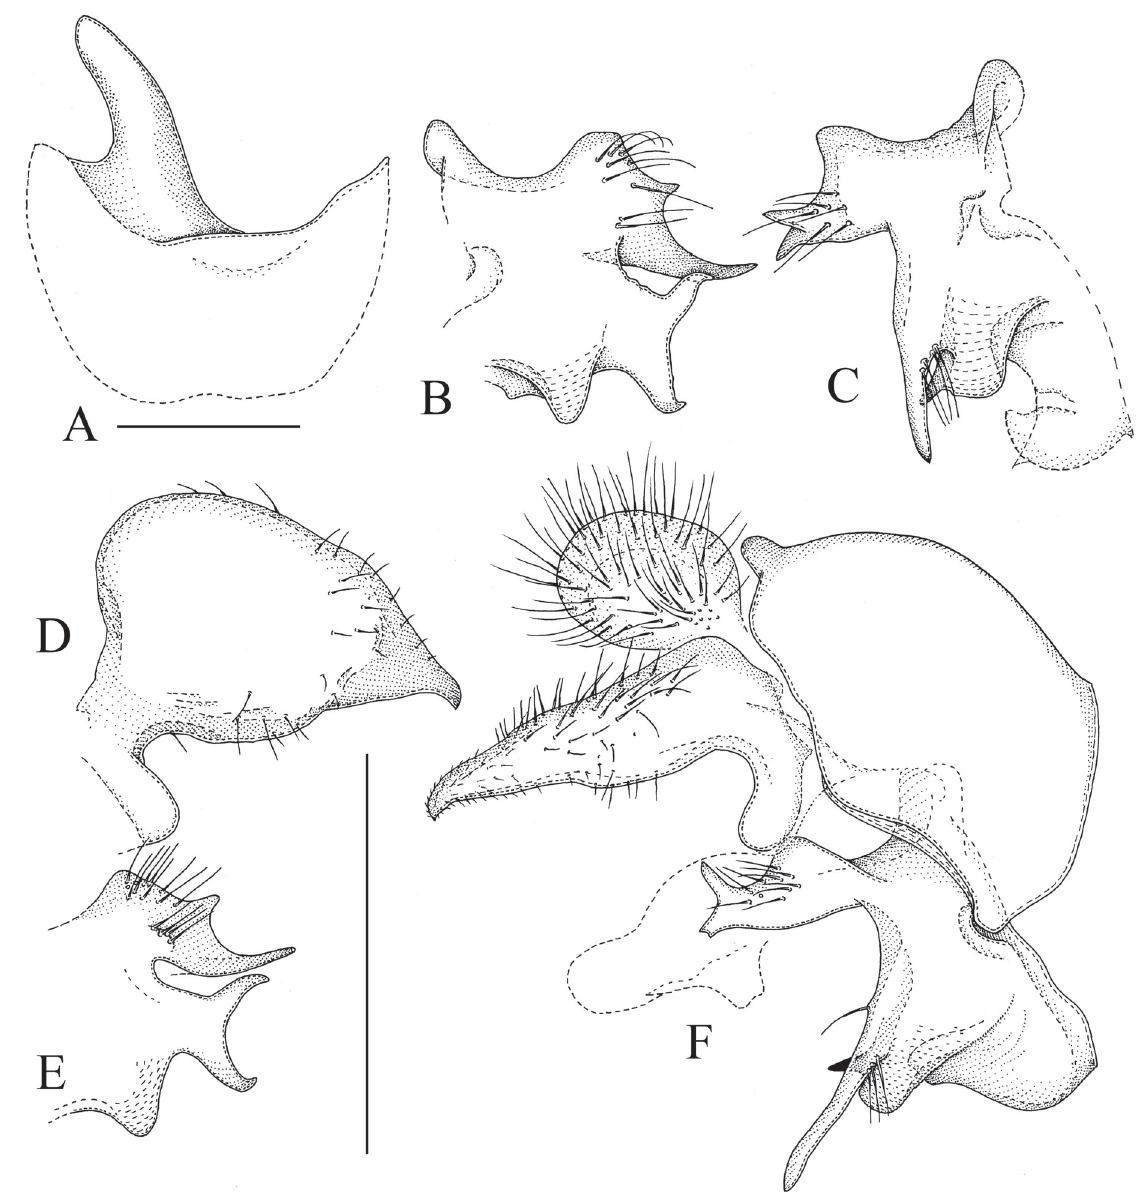
Fig. 74. Sphegina (Asiosphegina) philippina Thompson, 1999, holotype, ♂ (B–C) and paratype, ♂ , Mindanao (A, D–F). A . Sternum IV, ventral view. B, E . Left superior lobe, lateral view. C . Right superior lobe with associated parts, lateral view. D . Left surstylus, lateral view. F . Genitalia, right side, lateral view. Scale bars = 0.5